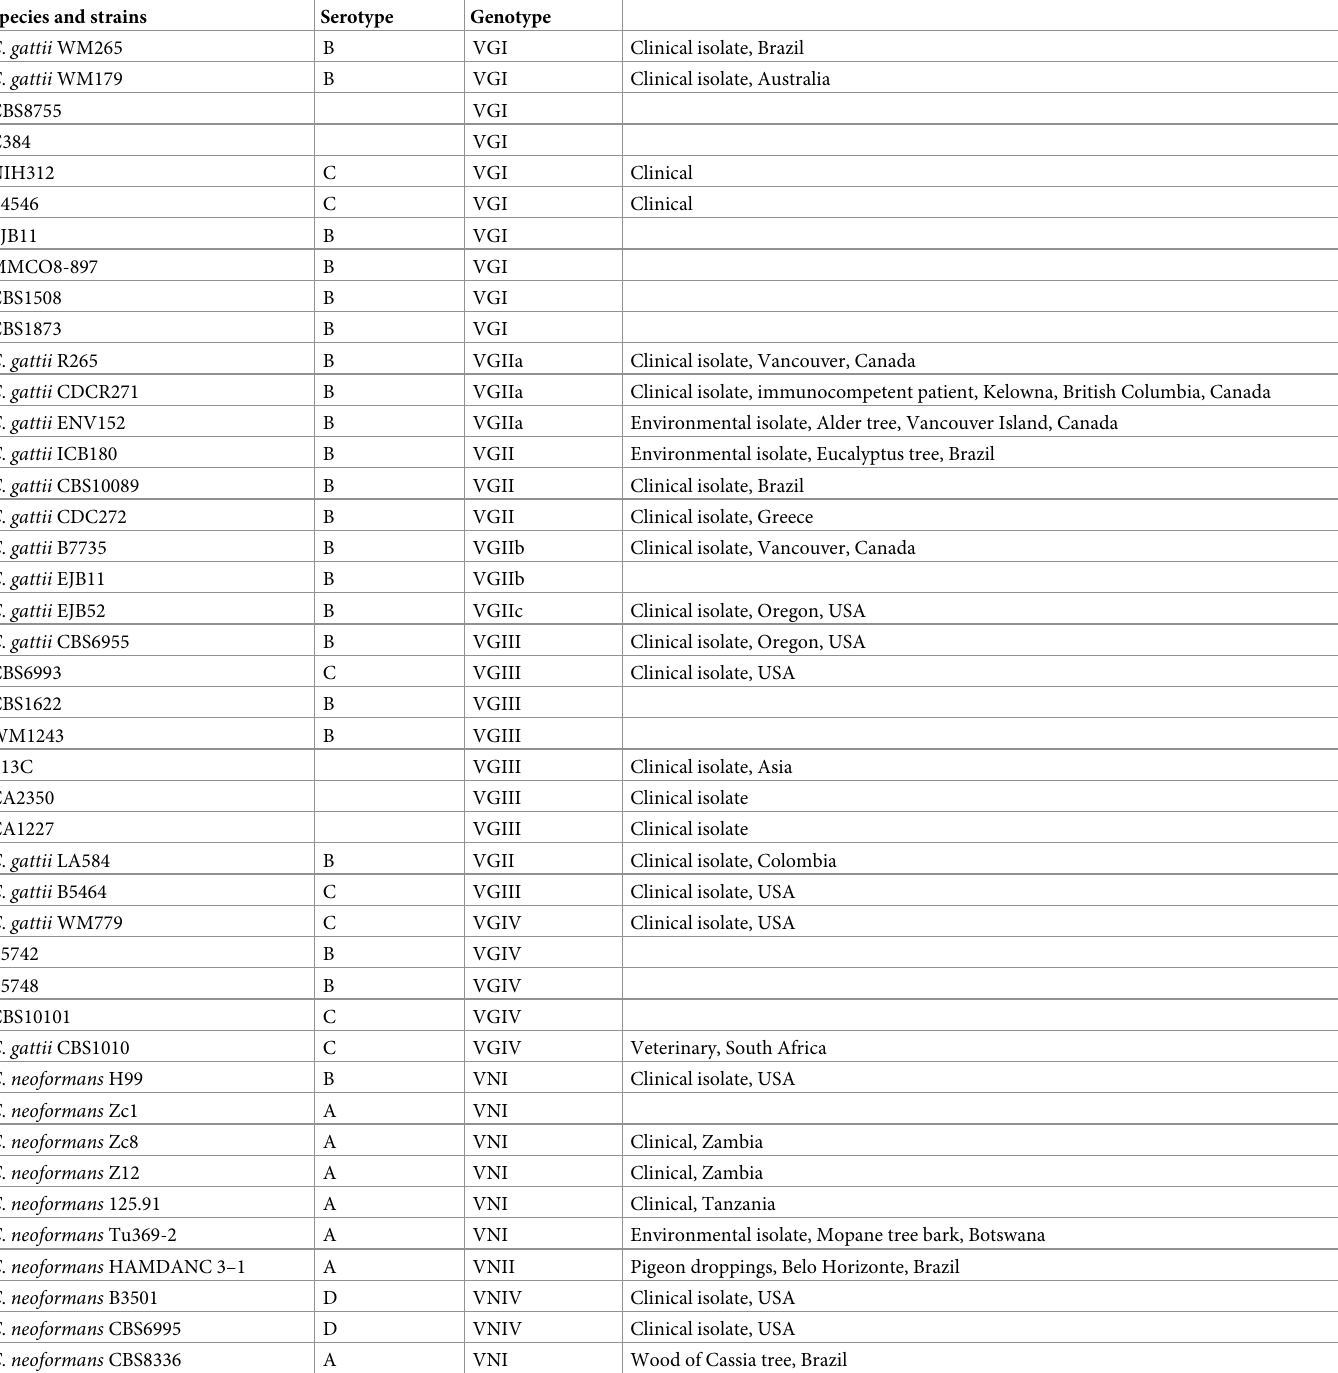
Table 2. Cryptococcal species and strains used in this